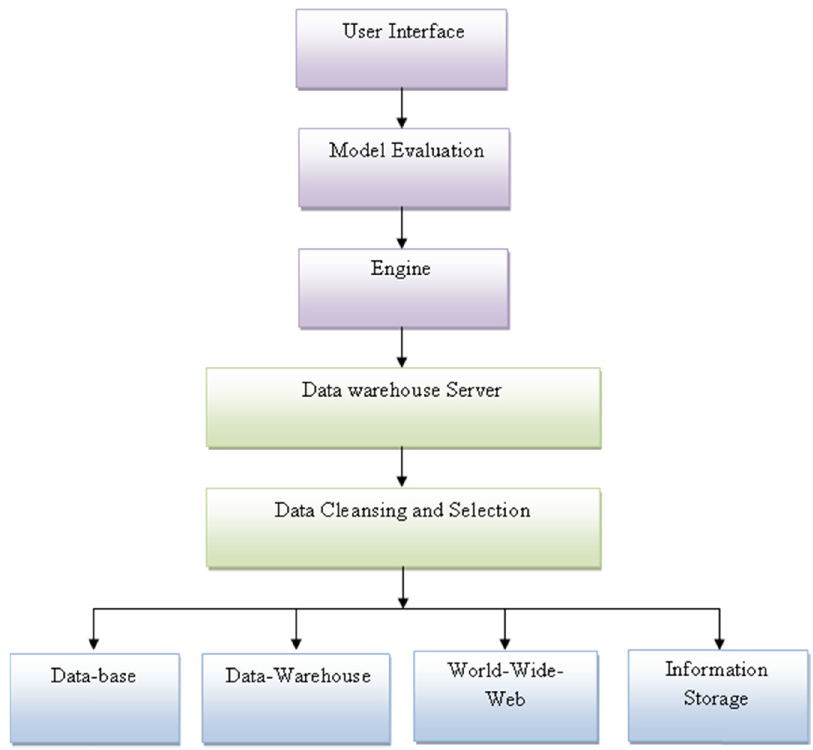
Figure 2: Technical structure of data